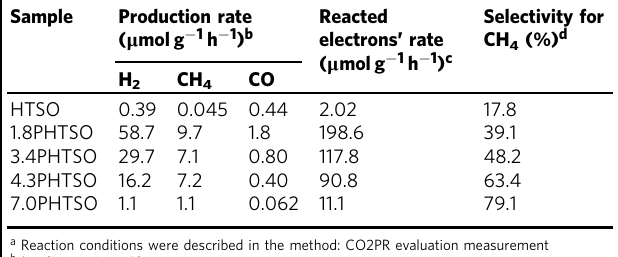
Fig. 3e show two sets of time constants, for 1.8PHTSO is τ 1 =